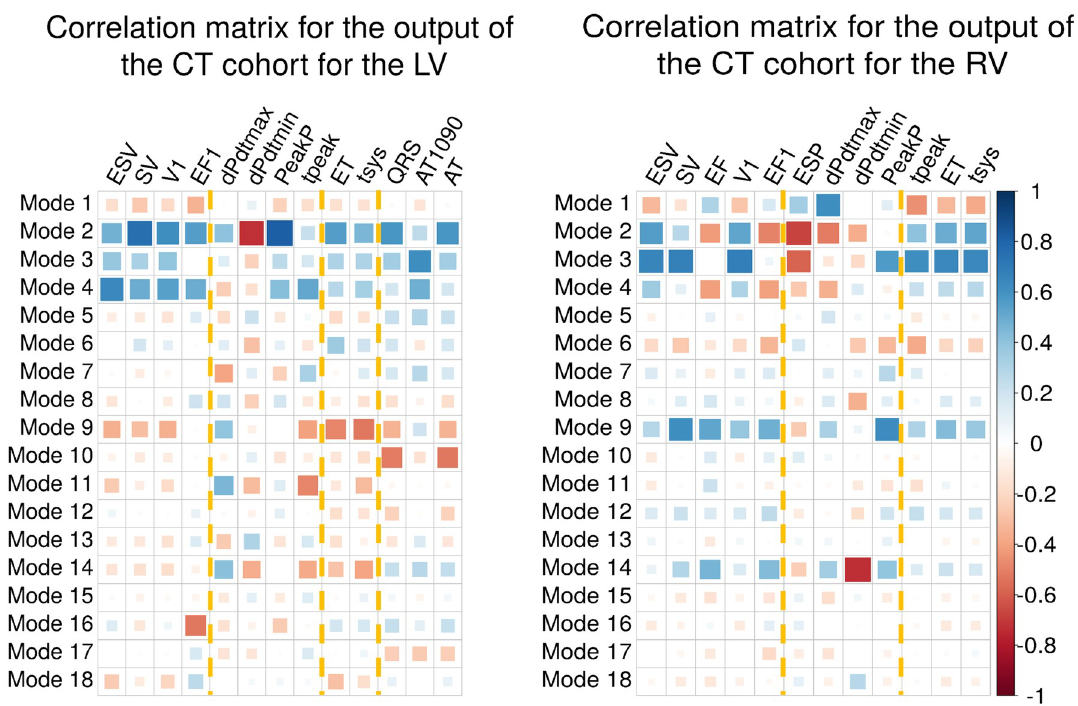
Fig 7. Correlation matrices for the CT cohort. Measurements for the LV on the left, and for the RV on the right. Colour indicates the sign of the correlation and the size of the squares how high is the correlation. Yellow dotted lines indicate each group of phenotypes: volume-based, pressure-based, time/duration-based and